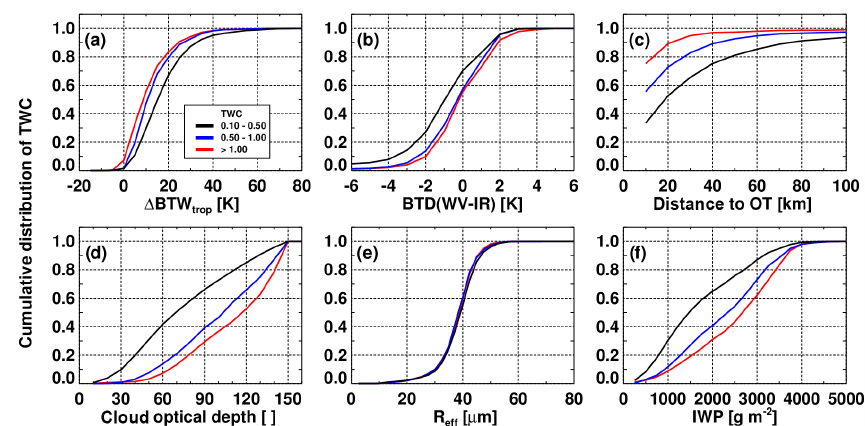
Figure 5. Cumulative frequency diagrams of satellite-derived (a) (cid:49) BTW, (b) BTD, (c) dOT, (d) COD, (e) Reff, and (f) IWP for the three TWC intervals indicated in the legend in panel (a)